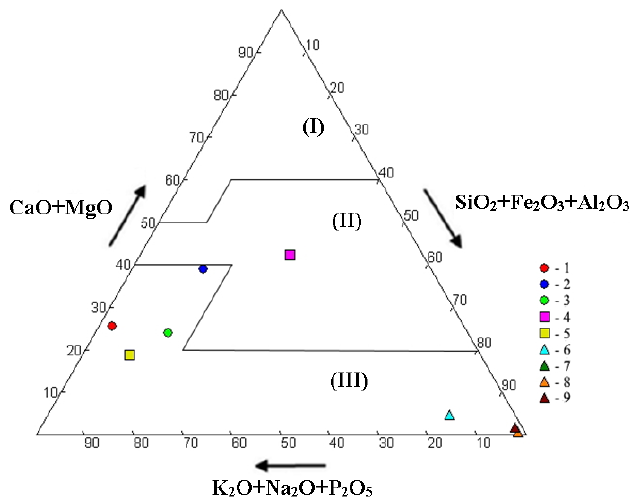
Figure 5. Triple diagram built on the basis of data from [24,25] and proposed in [23] to predict the behavior of biomass ash.